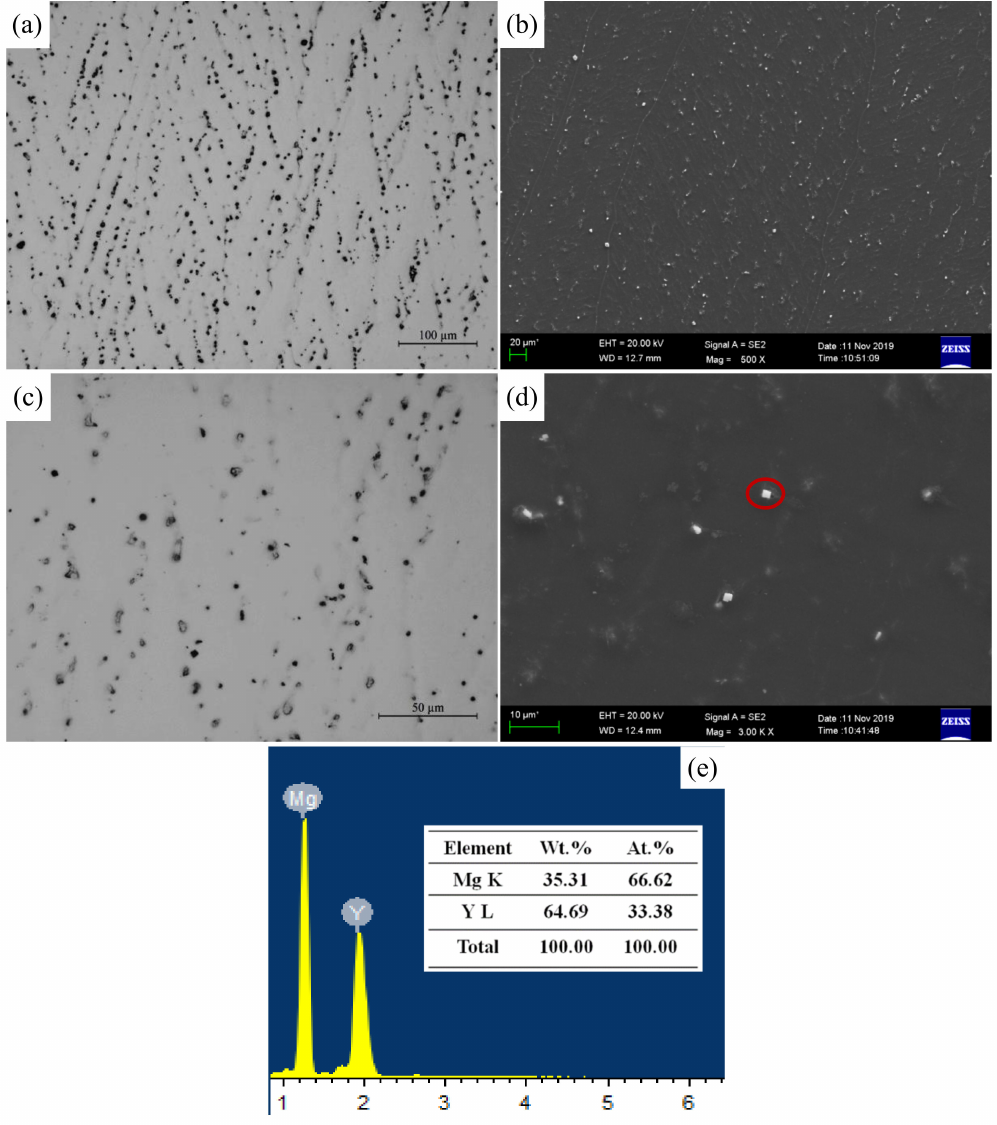
Figure 6. Optical micrographs of ( a ) low magnification view and ( b ) high magnification view; SEM micrographs of ( c ) low magnification view and ( d ) high magnification view; ( e ) the EDS results corresponded to the secondary phase marked by the red circle of as-cast Mg-3Y